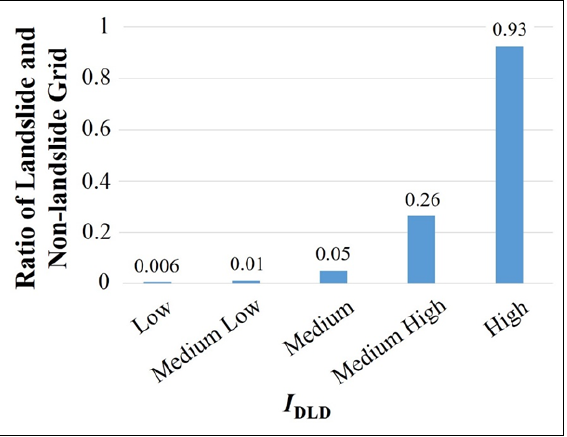
Figure 3. The degree of land disturbance I DLD against landslide grid ratio.